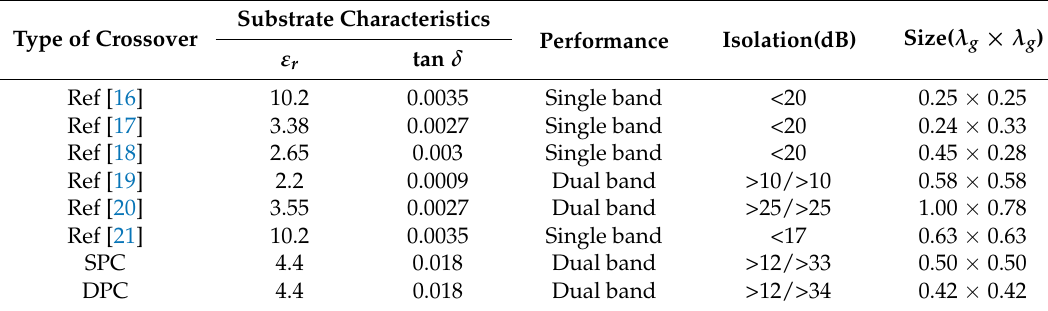
Table 2. Comparison of